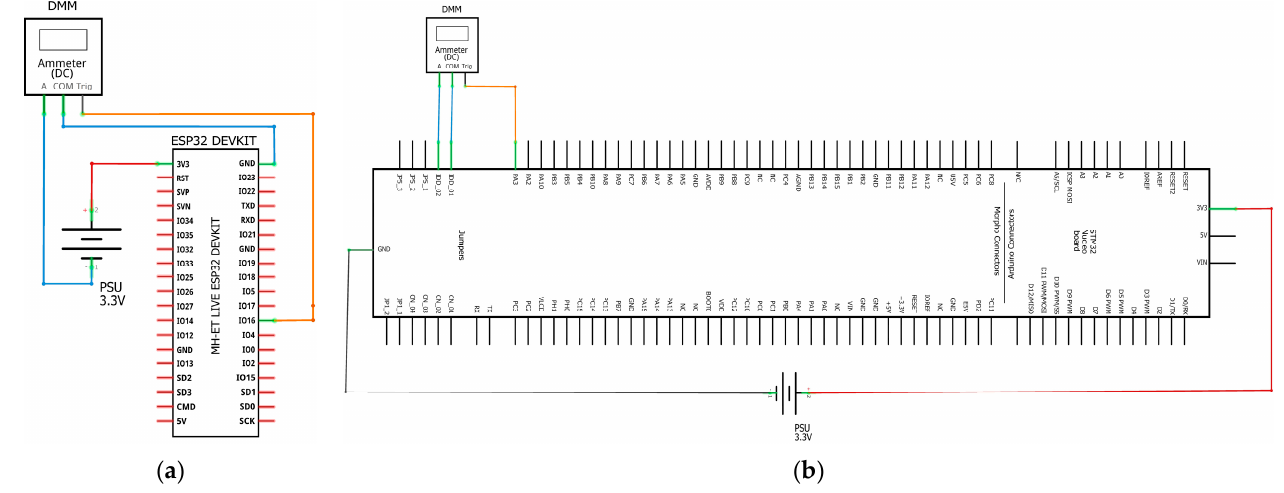
Figure 2. DMM Connection Diagram for Test Board ( a ) ESP32, ( b